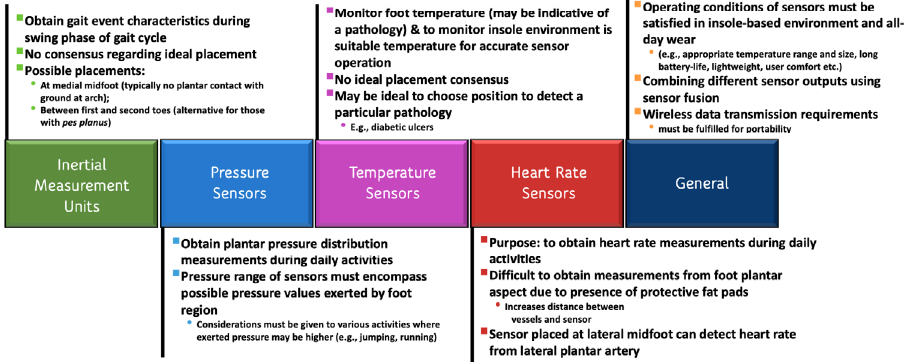
Figure 11. Challenges and considerations regarding the placement and use of various sensors in an insole-based monitoring